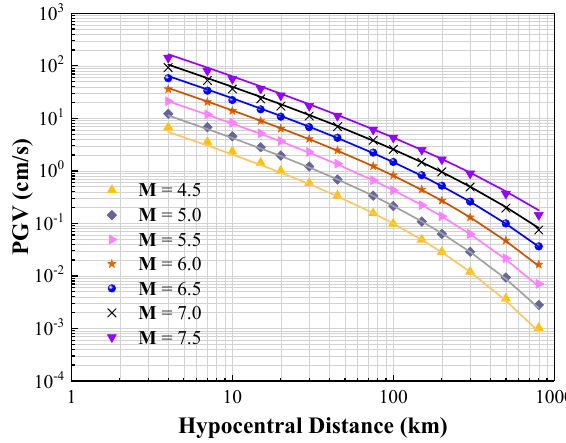
Figure 8. Simulated PGV values (symbols) for varying M values (M4.5–M7.5) and distances (4–800 km) shown alongside predictions by CAM (lines) for ∆ σ = 200 bar, V S30 = 0.76 km / s, and κ 0 = 0.025 s. Table 5. Coefficients of CAM for modelling PGV.